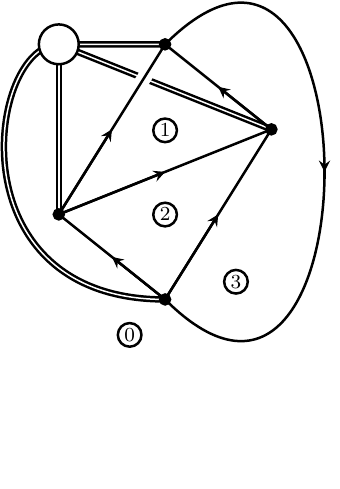
Figure 33 . A canonical choice of framing for the dual tetrahedron graph dressed by 1-form symmetry